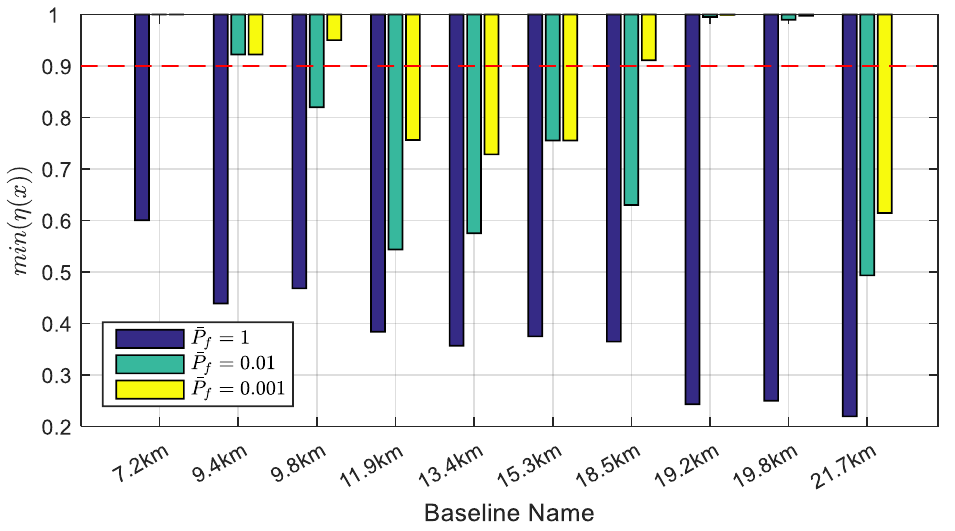
Figure 11. The minimum likelihood ratio of different baselines with the FF-approach.